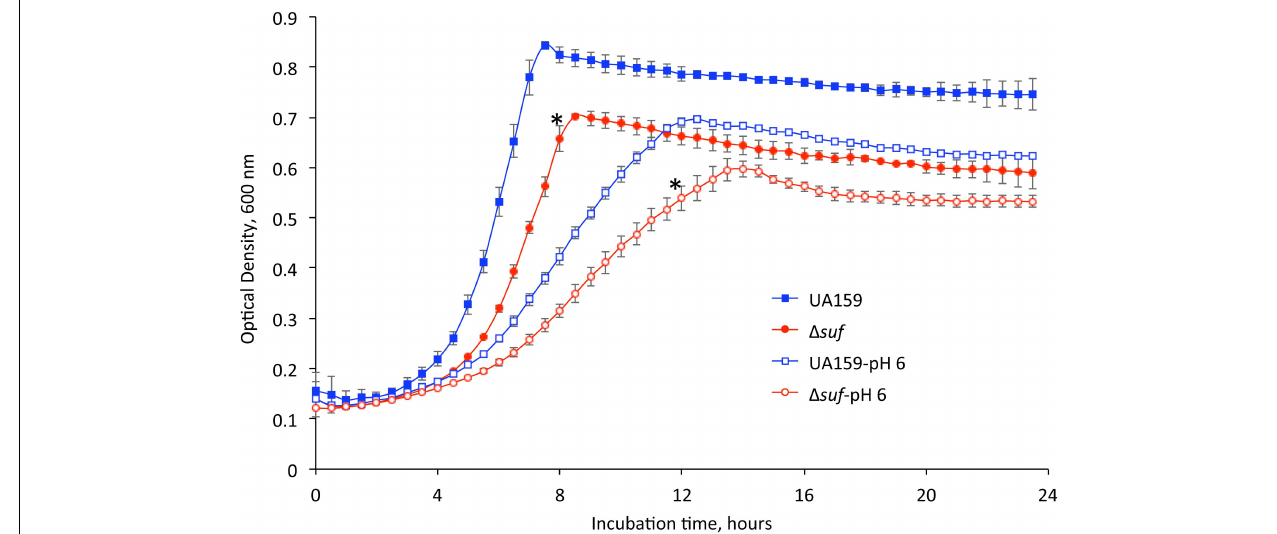
FIGURE 1 | Growth characteristics of the mutant strains. Streptococcus mutans wild-type, UA159 and the sufCDSUB- deficient strain, (cid:49) suf::kan r ( (cid:49) suf ) were grown in BHI broth and BHI broth with pH adjusted to 6.0. The optical densities of the cultures at 600 nm were recorded continuously using a Bioscreen C. Data presented here are representatives of three separate experiments with symbol * indicating a statistically significant difference in the doubling time between UA159 and (cid:49) suf::kan r under the same conditions with a P < 0.05.